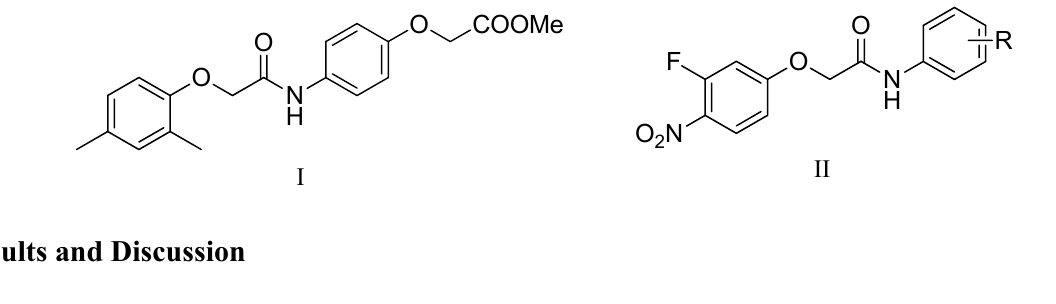
Figure 1. The chemical structures of methyl 2-(4-(2-(2,4-dimethylphenoxy)acetamido) phenoxy)acetate ( I ) and 2-(3-fluoro-4-nitrophenoxy)- N -phenylacetamide derivatives ( II